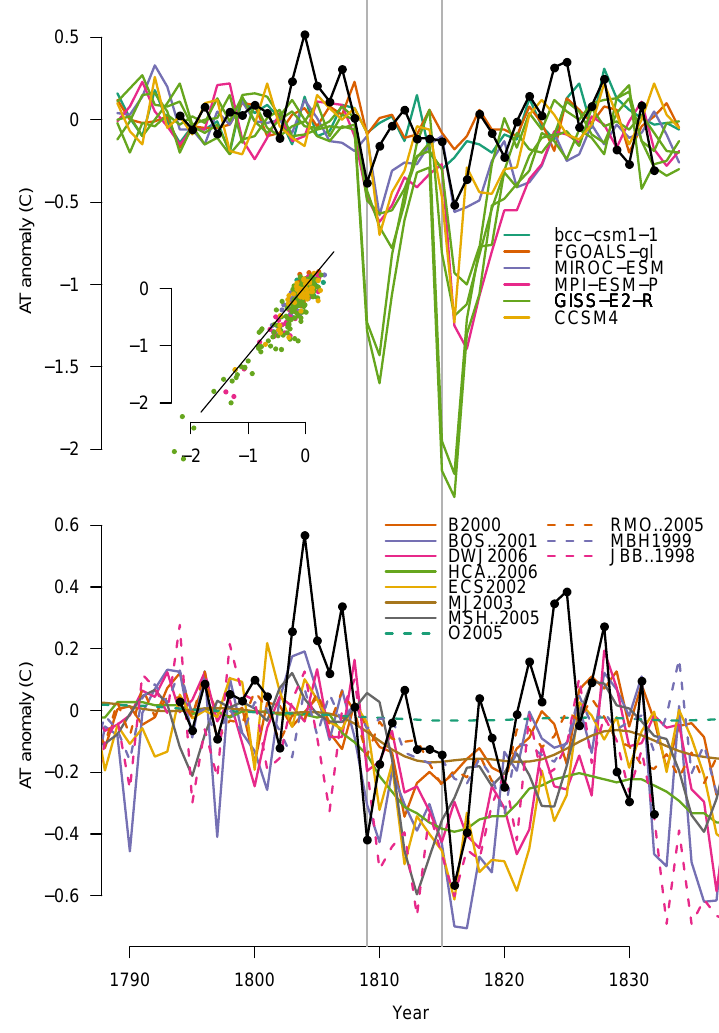
Fig. 9. Comparison of observed, simulated, and proxy-derived large-scale near-surface temperature variability over the early nineteenth century. Upper panel: tropical (observations coverage) marine temperatures from observations (black) and the CMIP5 simulations. Lower panel: Northern Hemisphere temperatures from observations (black) and proxy reconstructions. Inset: relationship between observations coverage ( x ) and Northern Hemisphere ( y ) temperature in the simulations, with best fit line (slope 1.2). All series normalised to have mean zero over 1795–1805. The grey vertical lines mark the dates of two large volcanic eruptions (1809 and 1815). Data used is listed in Table 1.